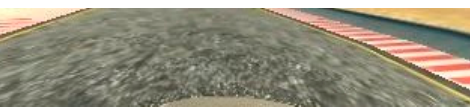
Figure 10. Input image after the cropping.